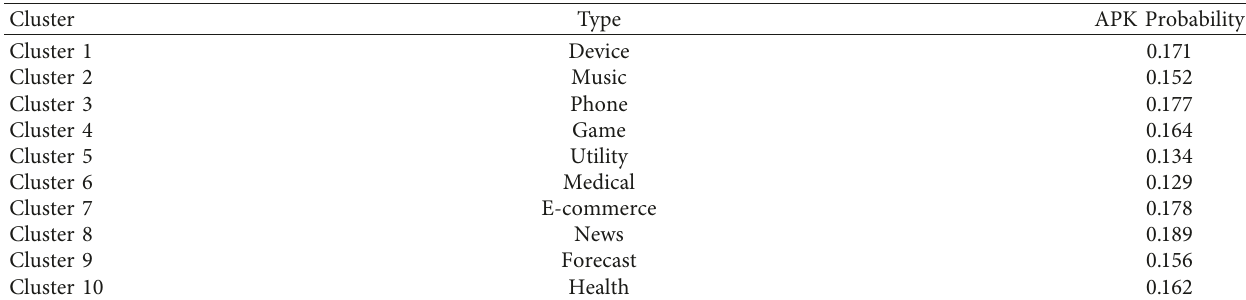
Table 10: Clusters formation